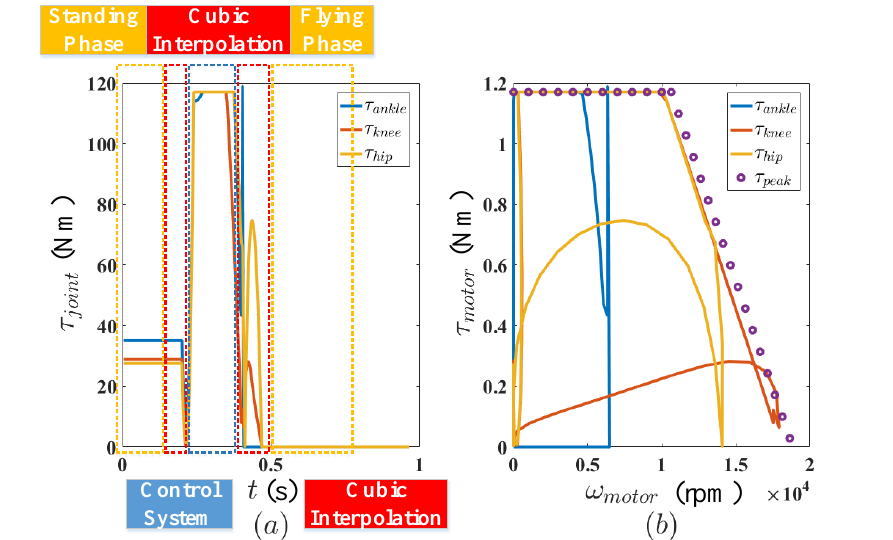
Figure 15. ( a ) shows the torque of each joint in the simulation; and ( b ) represents relationships between the motor torque and speed in the simulation.